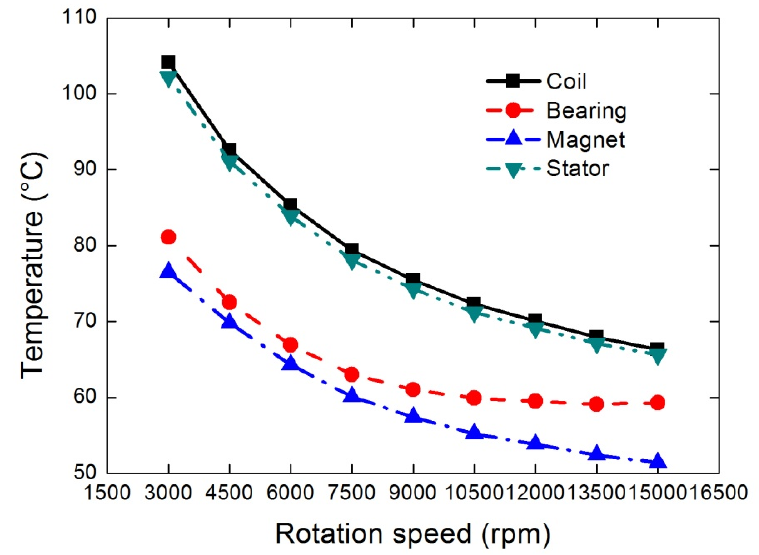
Figure 10. Temperature variations with respect to rotating speed of ISG (ambient temperature: 25  C).